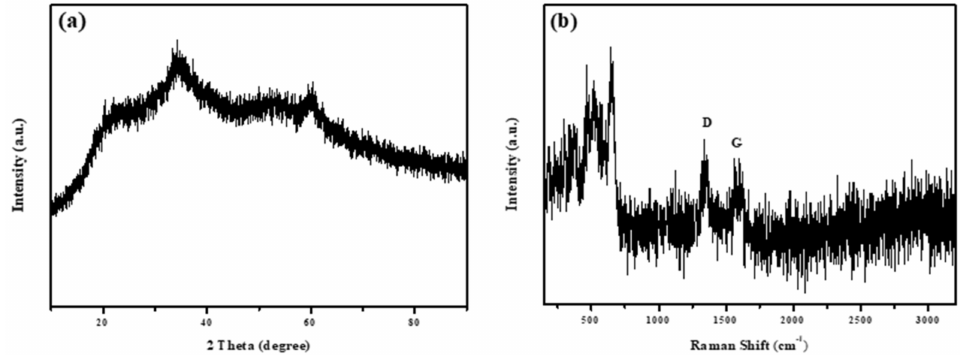
Figure 6. ( a ) XRD pattern and ( b ) Raman spectrum of NiCo 2 S 4 /rGO (D, G: Characteristic peaks of